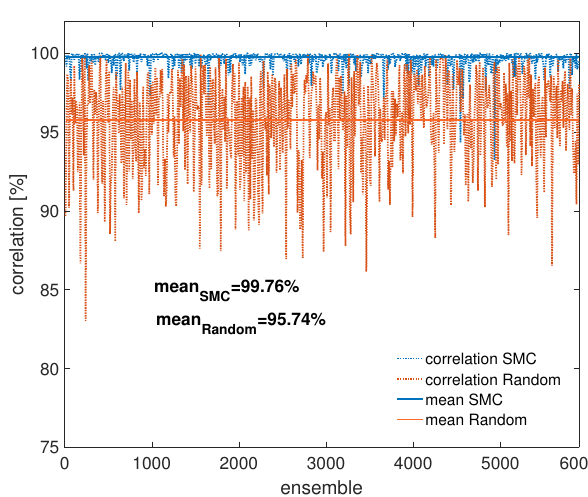
Figure 3. Correlation coefficients using Specified Mode Combinations (SMC), respectively, random mode combinations for training the DNN. For better readability, an exemplary selection of the ≈ 6000 results are depicted in the